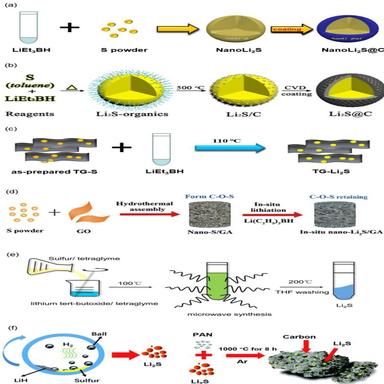
The schematic illustrating the reaction between Li-compounds and S to make Li2S-C composites. (a) Core-shell nano Li2S@carbon composites . (b) Li2S@C spheres by using toluene as auxiliary reagent. (c) TG-Li2S electrodes. (d) Li2S/GA electrodes via in-situ processes. (e) Li2S via microwave synthesis. (f) Li2S and the Li2S-C composite via ball-milling LiH and elemental sulfur. Reproduced from Refs. with permission from Royal Society of Chem